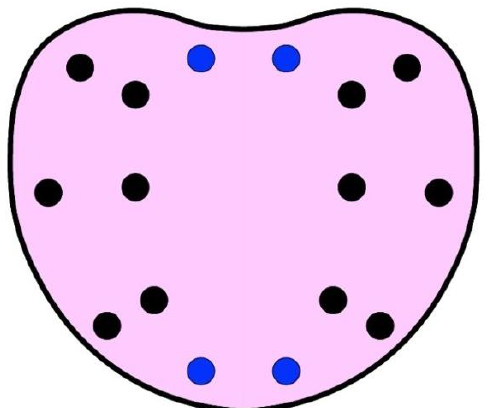
Figure 1. Scheme of systematic template for prostate biopsy. Black dots represent systematic biopsies. Blue dots represent additional systematic biopsies according to prostate volume (>60 mL).